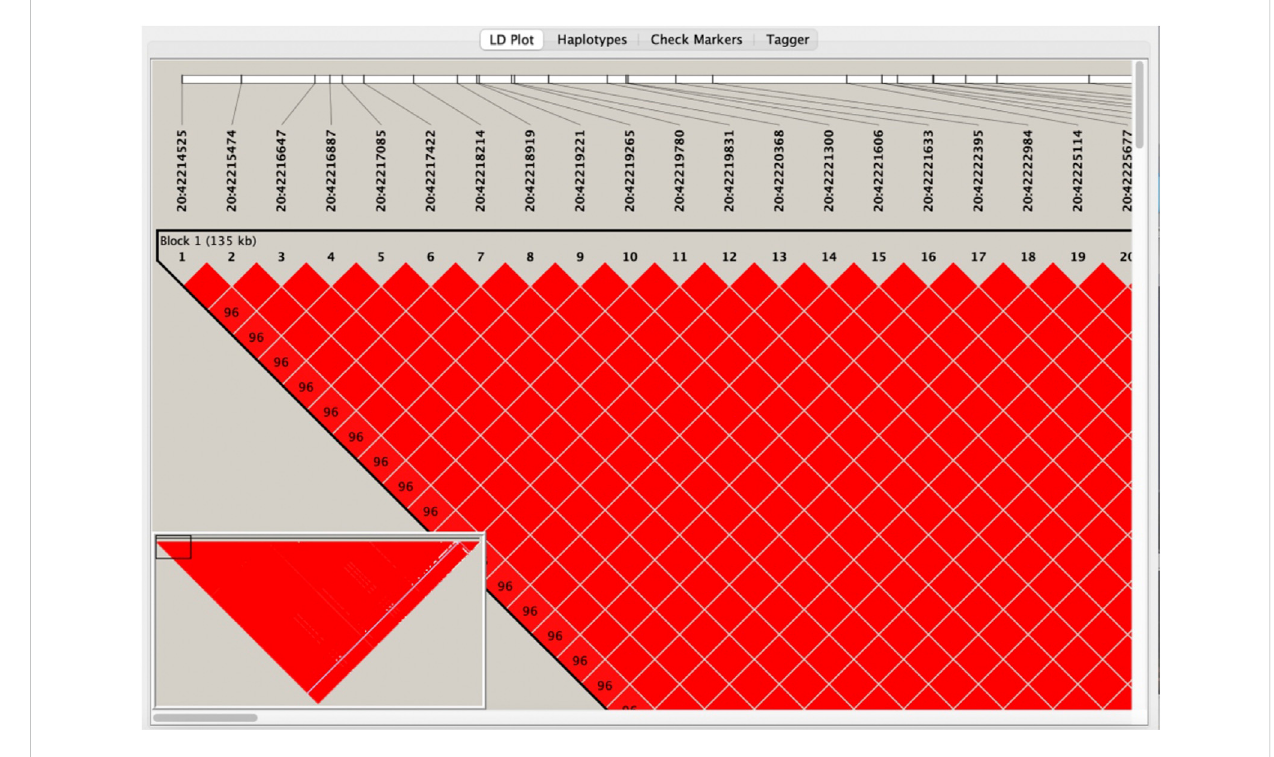
FIGURE 2 Visualisation of linkage disequilibrium analysis by